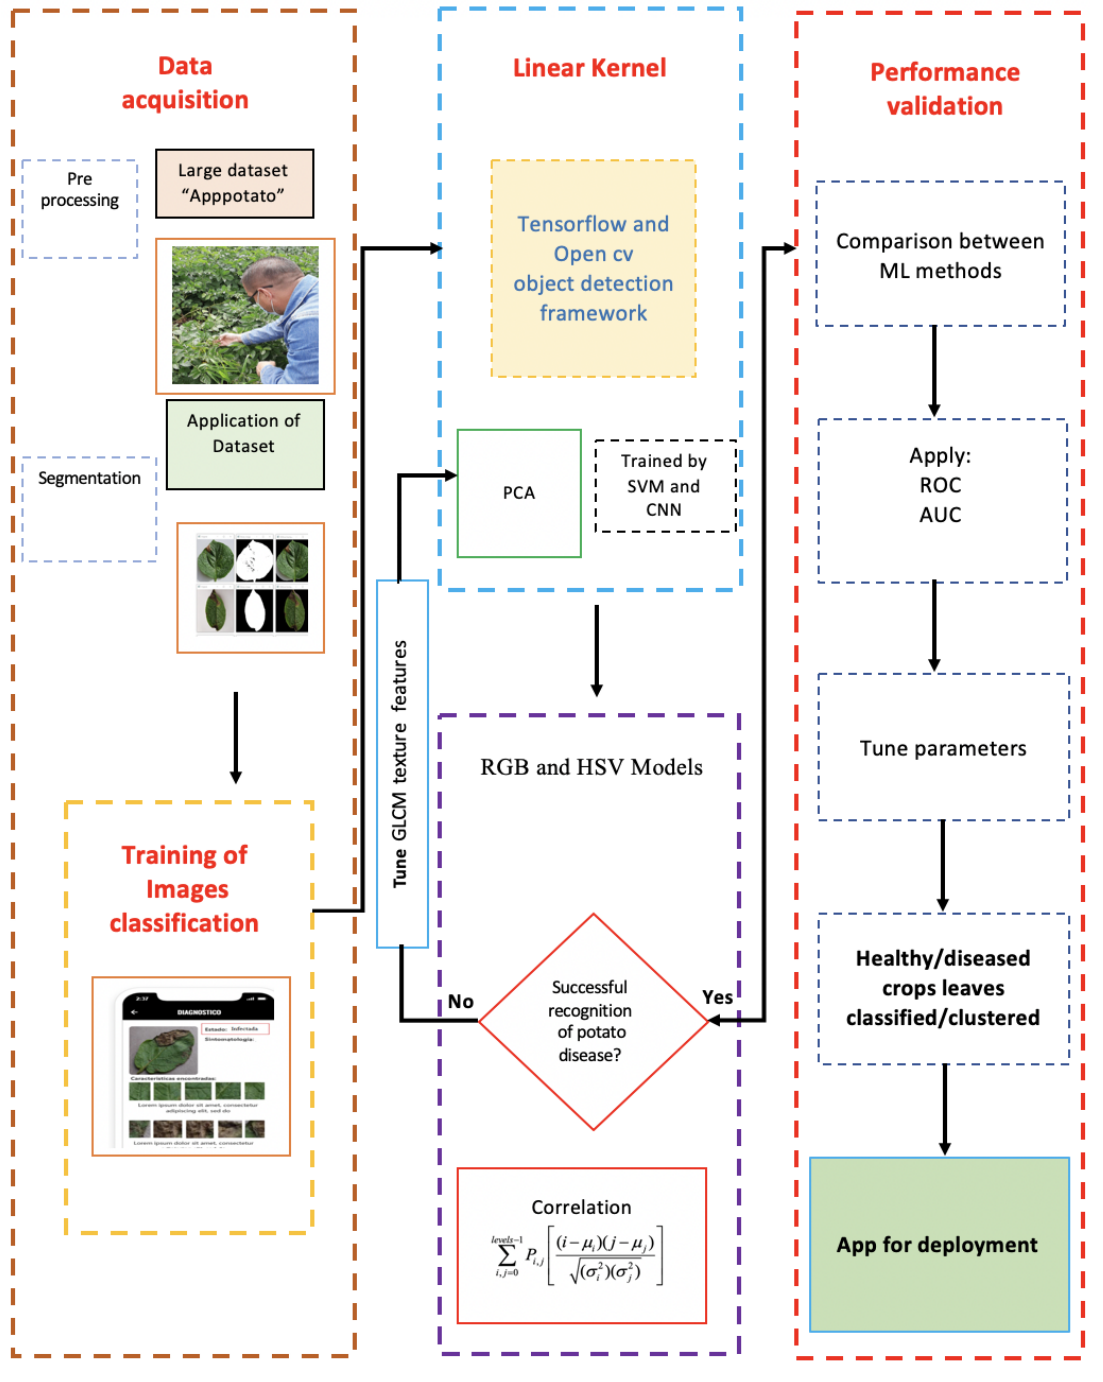
Figure 1. The flowchart of the